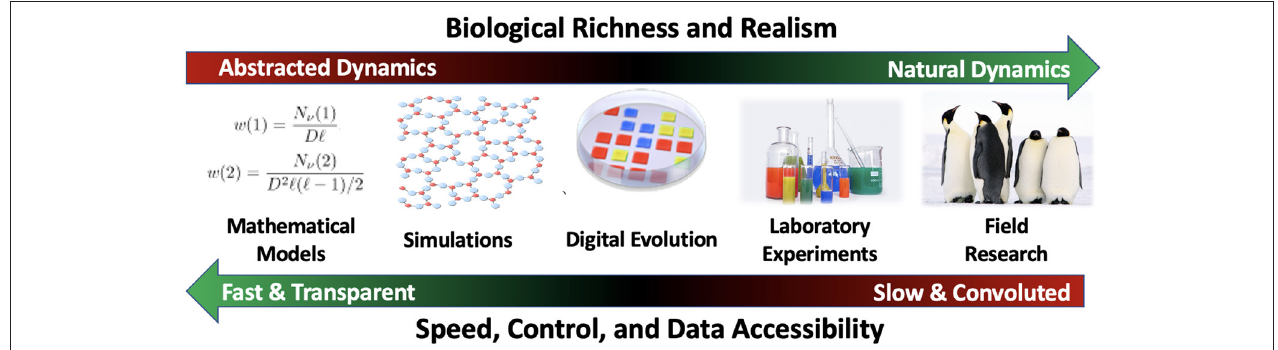
FIGURE 1 | Continuum of study system richness vs. ease of interpretation. In choosing a system in which to study ecological or evolutionary questions, there are inherent trade-offs to be made. As systems become more abstract, they can be made faster and easier to interpret. However, they may fail to capture important aspects of the dynamics observed in nature. Conversely, systems with dynamics that better reflect nature are more challenging to study. Indeed, study systems at all points along this continuum can provide useful insights into different aspects of ecology and